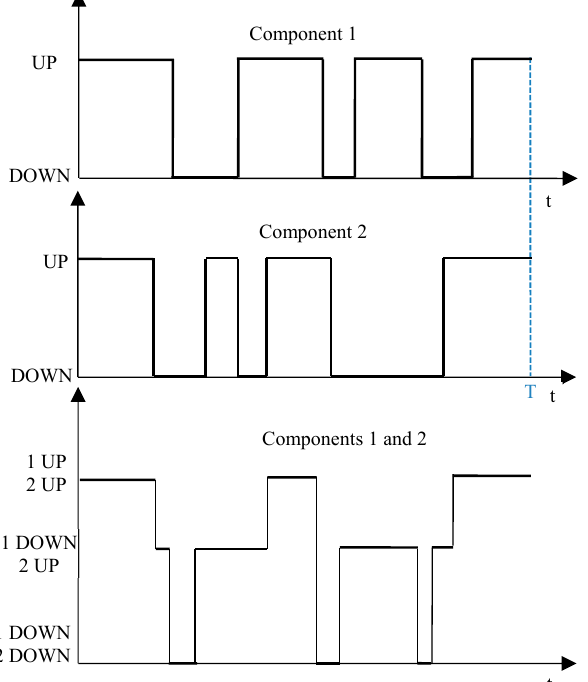
Figure 5. Graphical representation of the working history of a simple system consisting of two components.